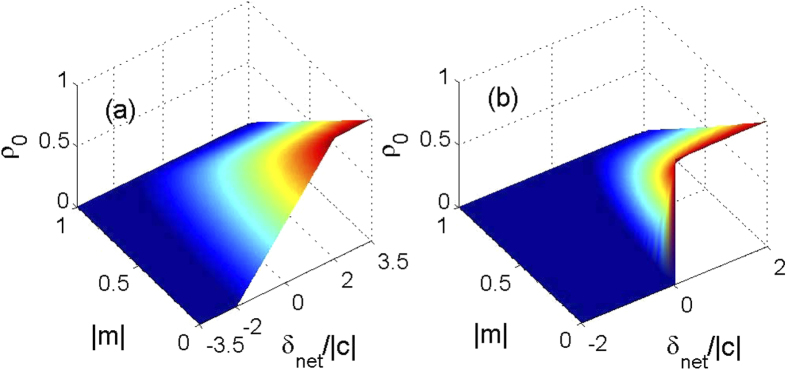
The fractional population in the MF ground state.The fractional population ρ0 for the ground state in the hyperfine state mF = 0 versus δnet and magnetization m for (a) ferromagnetic spinor (87Rb with c < 0) and (b) antiferromagnetic spinor condensates (23Na with c > 0).